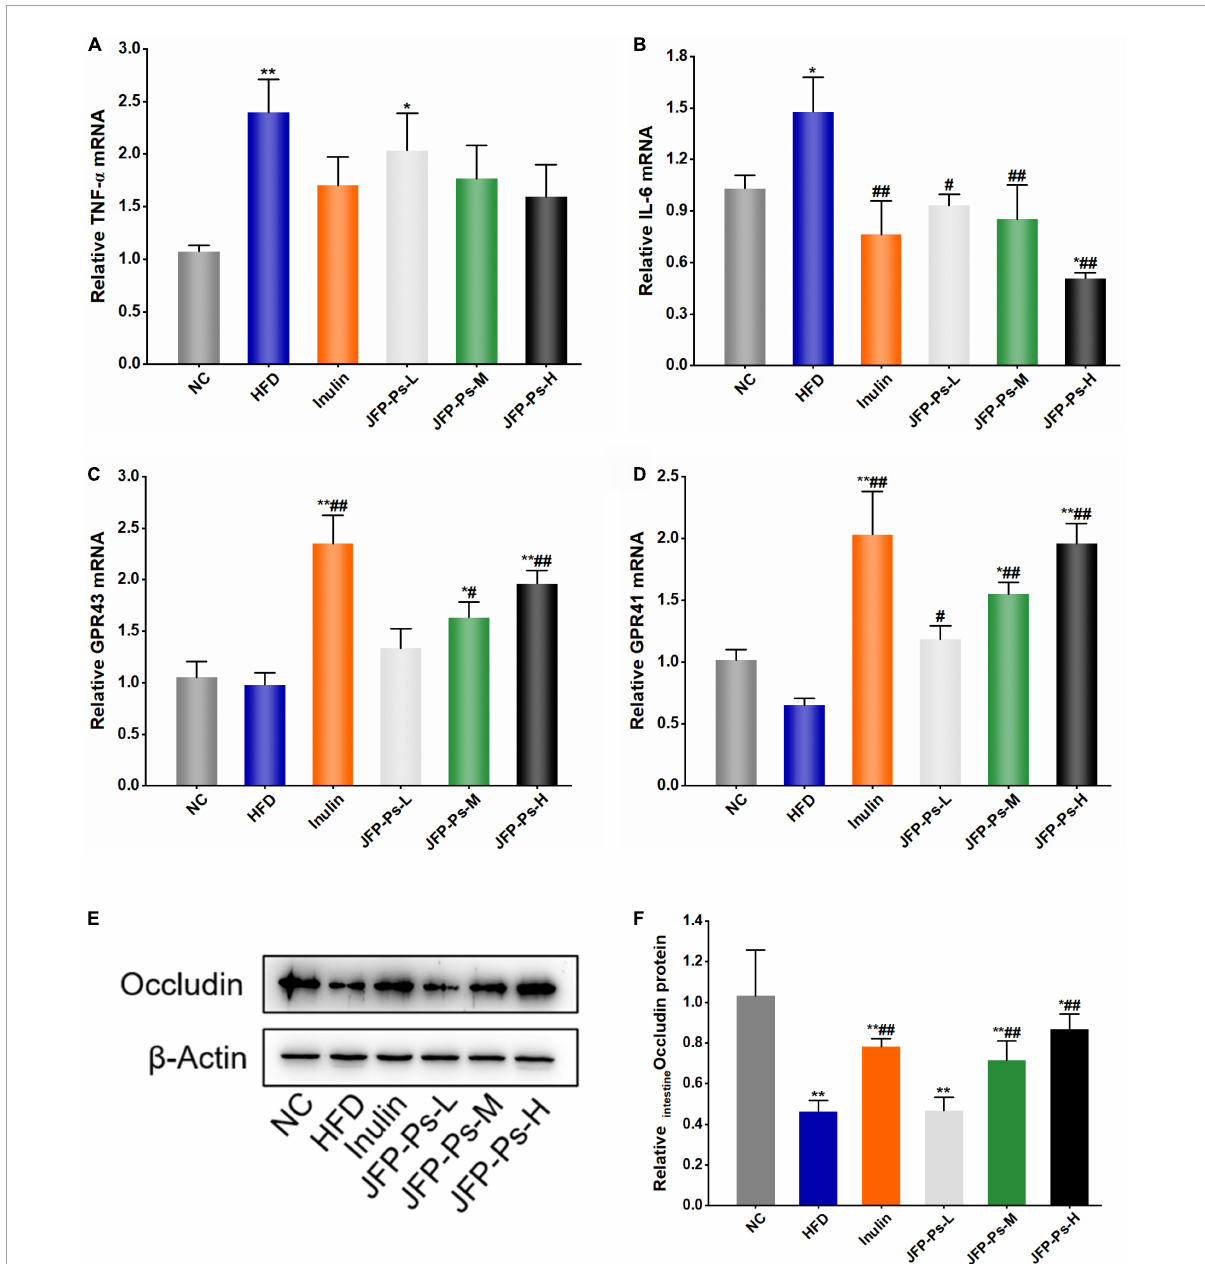
FIGURE4 Effect of JFP-Ps on the expression of inflammatory genes, free fatty acid receptor genes and tight junction protein in the small intestine of obese rats. (A) TNF- α , (B) IL-6, (C) GPR43, (D) GPR41, (E) protein expression of occludin, (F) relative band intensities of occludin. Data are expressed as mean ± SEM ( n = 6 for each group) and analyzed using one-way ANOVA. * p < 0.05, ** p < 0.01 compared to the NC group; # p < 0.05, ## p < 0.01 compared with the HFD